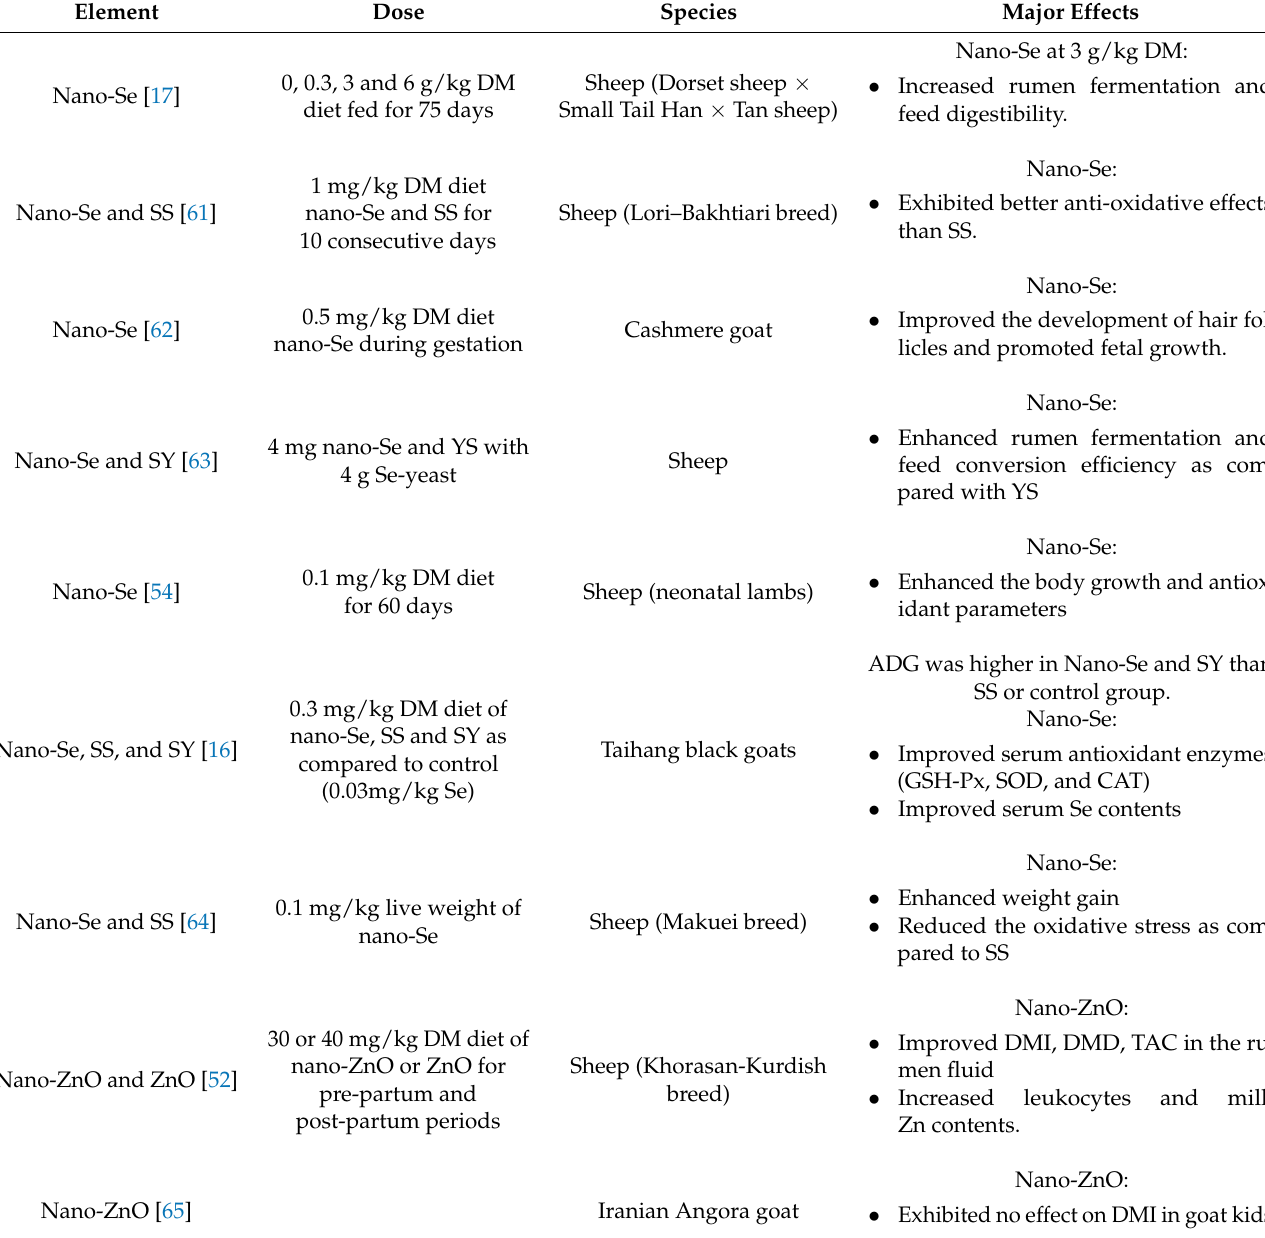
Table 1. Effects of nanominerals on growth performance, feed digestibility, and milk yield parameters in ruminants.